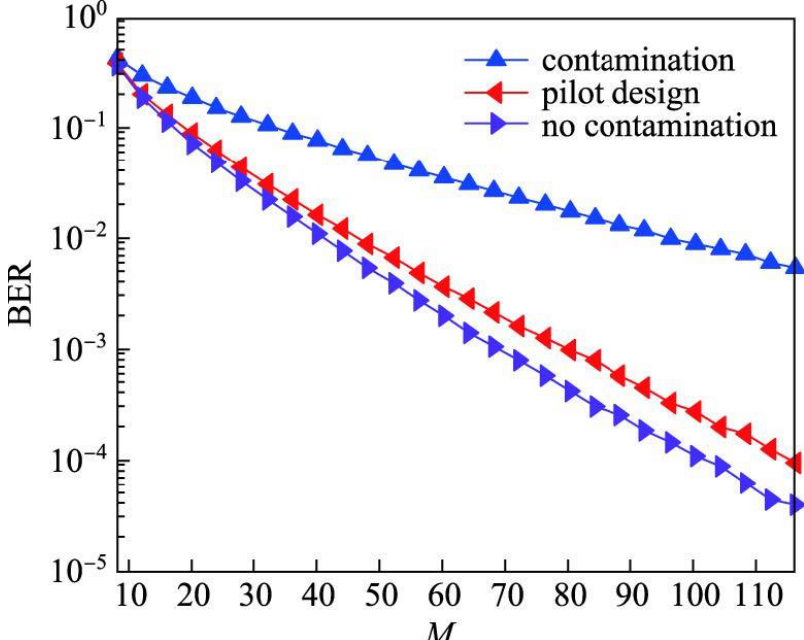
Figure 16. Comparison of the BER of the proposed pseudo-random pilot design scheme with other schemes against the number of BS antennas.